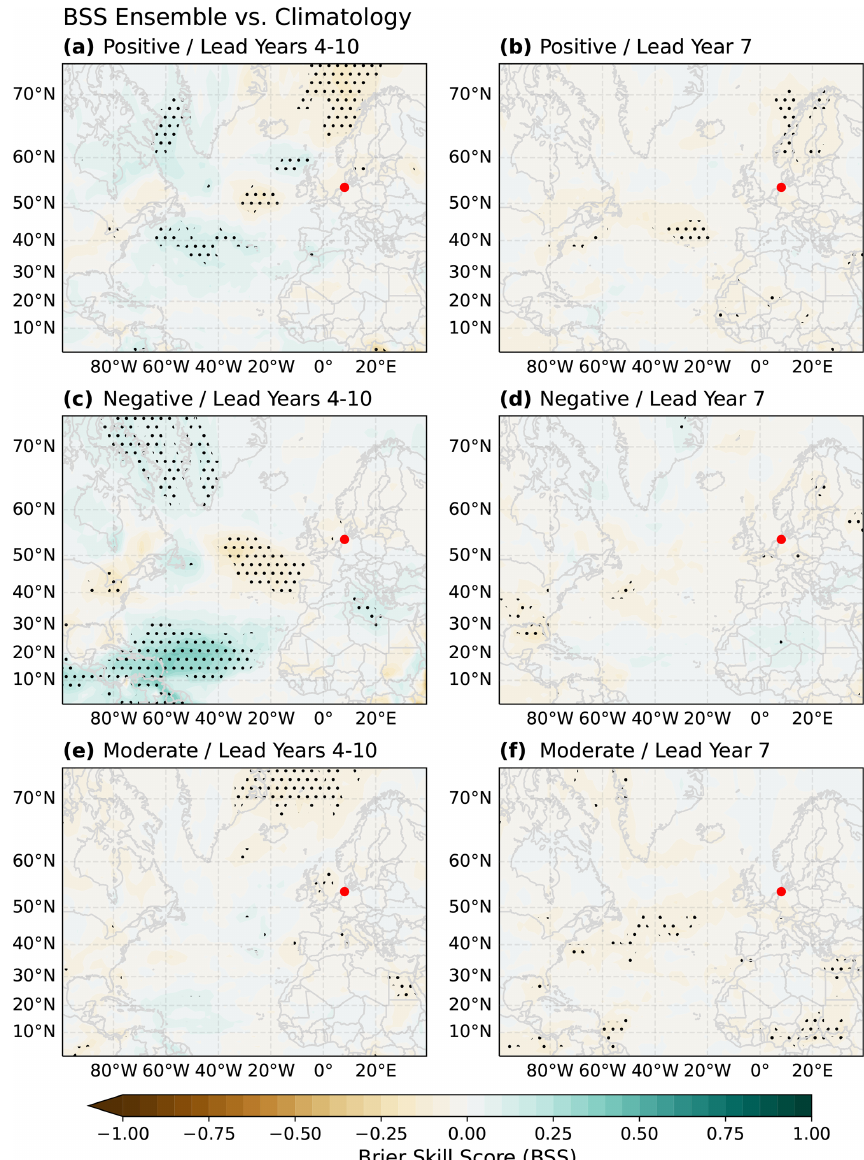
Figure 7. Like Fig. 6 but evaluated against a climatology-based prediction as a